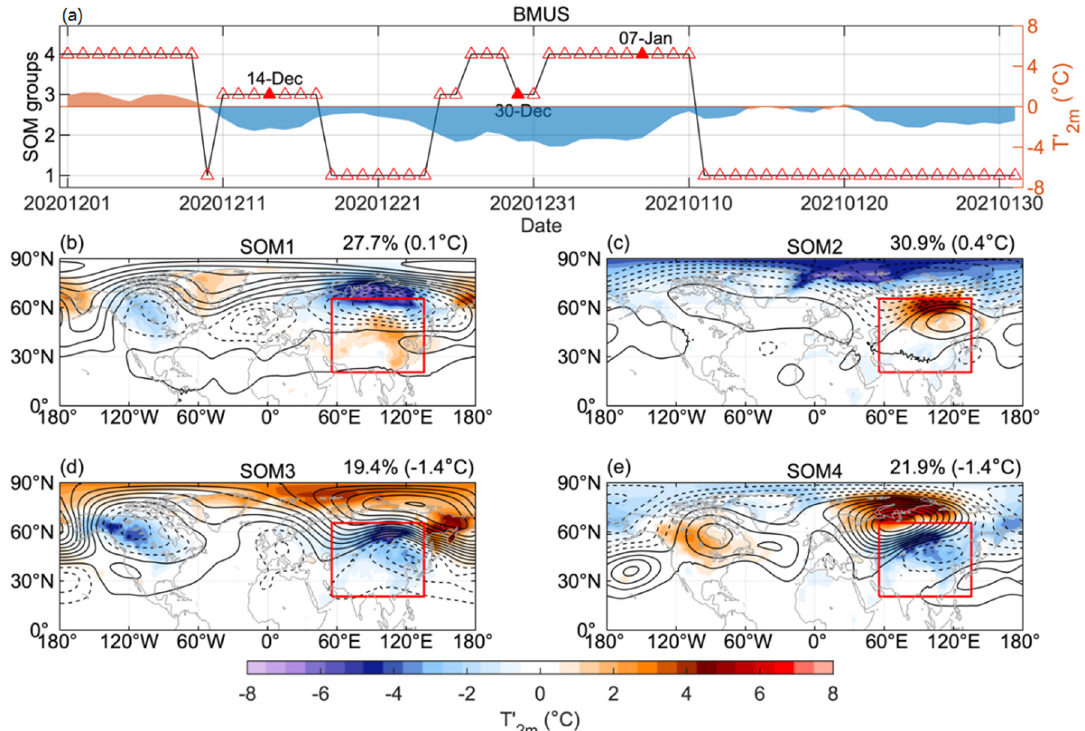
Figure 3. The 2 × 2 SOM groups exacted by the joint clustering analysis on the daily Z500 and T 2m anomalous fields in East Asia (25° N–90° S, 40° E–20° W) in boreal winter (DJF) from 1950/1951 to 2020/2021. ( a ) The transition between different groups was revealed by the best-match units (BMUS) series of SOM clustering and the anomalous East-Asia temperature during the time period of the cold surge in the 2020/2021 winter. ( b – e ) Composites of the anomalous daily Z500 (contours) and T 2m (shaded), where the contour interval of Z500 is 15 m with the shaded for the T 2m anomaly passing 95% two-tail t -test. At the top-right corner of each plot, the percentage and temperature value in the bracket are, respectively, the ratio and East-Asia temperature change of each SOM group.